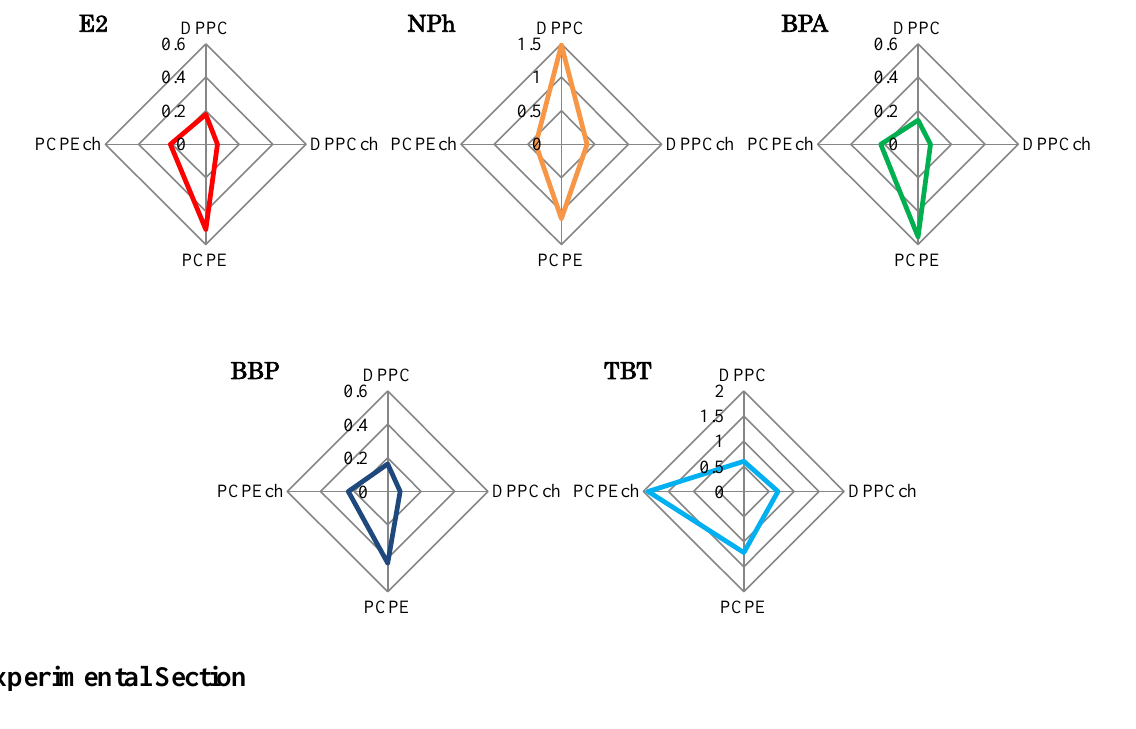
of EDCs and E2. The I F